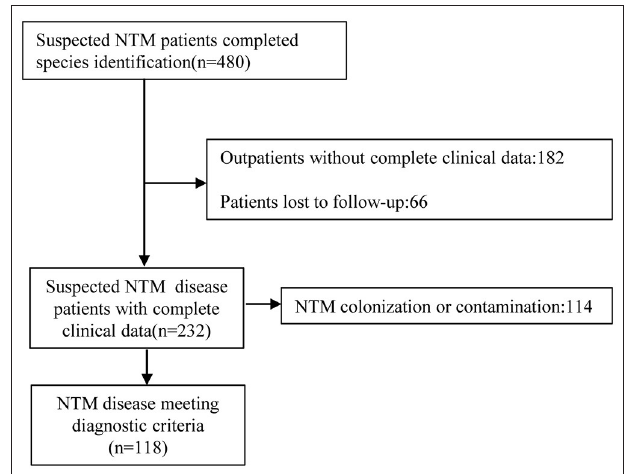
FIGURE 1 | Study flow